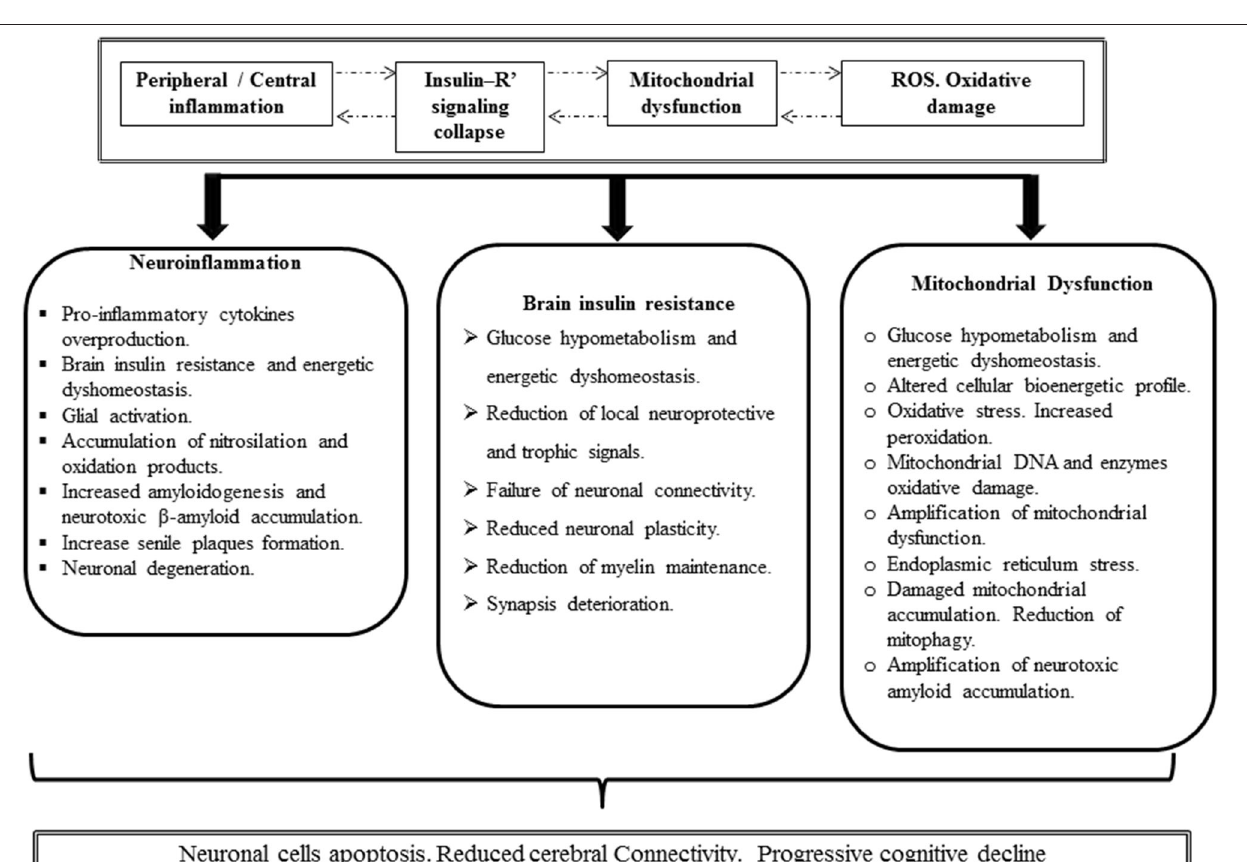
FIGURE 4 | Putative Alzheimer’s disease (AD) pathogenic integrative mechanism. Inflammation (either peripheral or central), IR, mitochondrial functional impairment, and the excessive production of ROS with the ensued oxidative damage are concatenated and mutually cooperate as pathogenic drivers. It is likely that one of these four ingredients can consistently drive to others so that a hierarchy of events may turn irrelevant. Inflammation breaches the BBB with the downstream consequences, elicits a neurotoxic environment, and triggers glial and astrocyte activation with further cytokine spillover. Oxidative stress may be an inflammation by-product that in turn amplifies inflammation. Concurrently, free radicals may turn on inflammatory pathways. Moreover, proinflammatory cytokines trigger IR by imposing a loss-of-function pattern of phosphorylation in insulin receptor substrate 1. Importantly, obstruction of cerebral insulin physiology translates neuronal cell vulnerability to inflammation, mitochondrial impairment, and oxidative stress and may be an amplifying factor to each of these nosogenic links. Furthermore, the functional collapse of cerebral insulin leads to increase of β amyloid accumulation, neurotoxicity, and ultimately neuronal demise. Impaired mitochondrial function either by an acquired or inherited defect or via β amyloid accumulation may turn sufficient to dismantle cerebral cell